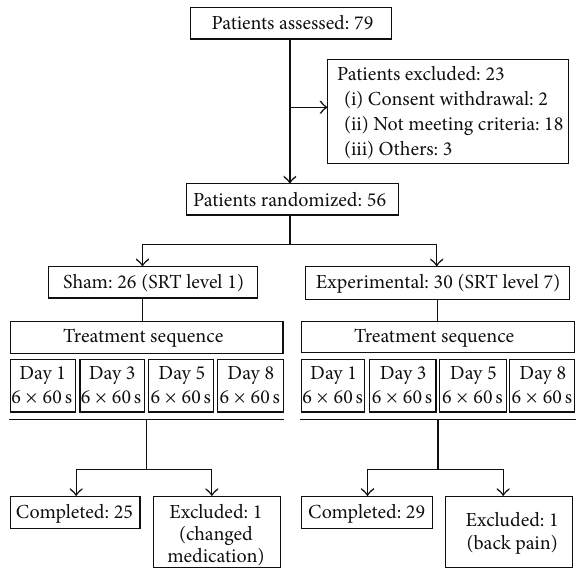
Figure 1: Flow chart of participants included in this study. The numbers indicate the number of patients in each